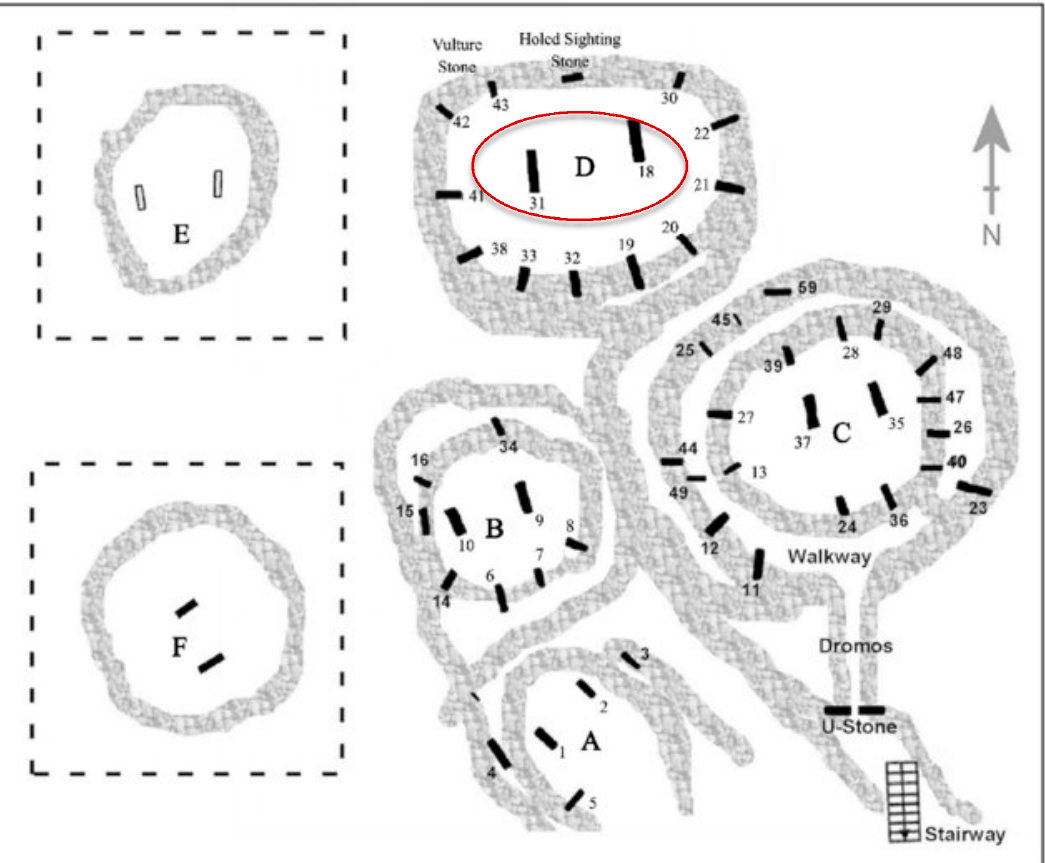
Figure A1. Photographs of anthropomorphic pillars from Göbekli Tepe, showing clear detail of arms, hands, belt, and loincloth. These pillars reached as much as 5 m in height and were centrally located in each enclosure. (Google Images)